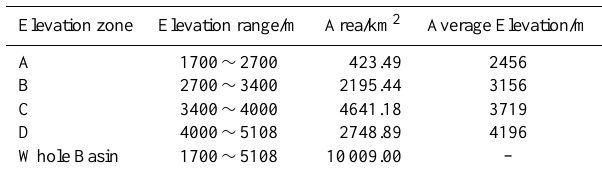
Table 1. Elevation zones and areas of the upper basin of Heihe River.